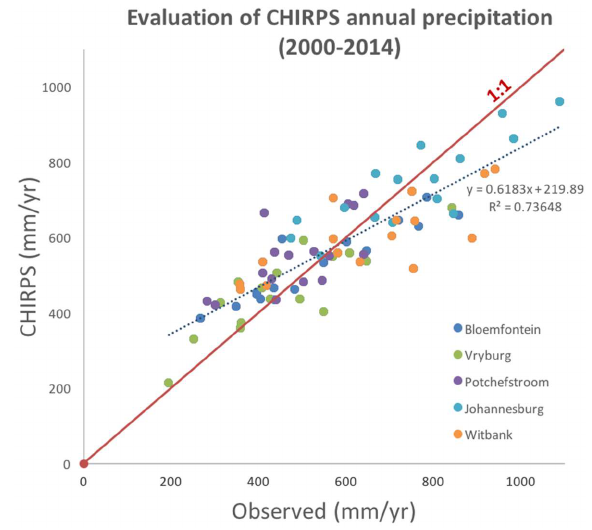
Figure A1. Correlation between CHIRPS pixel and weather station annual precipitation.